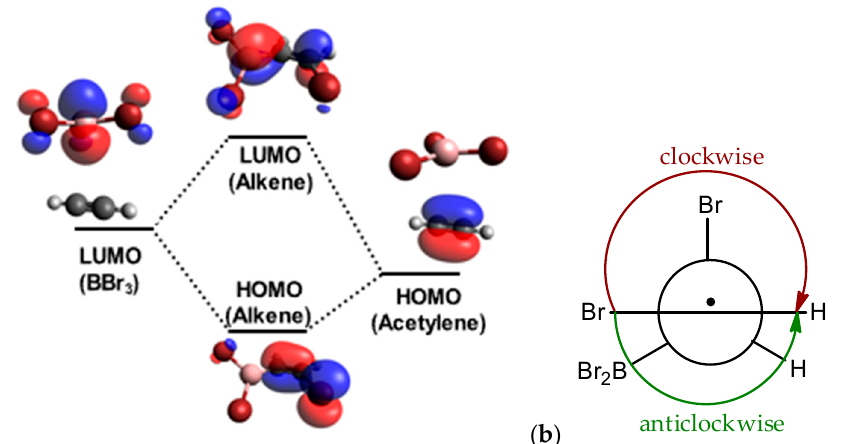
Figure 1. ( a ) Dispersion-corrected B3LYP and ( b ) MP2 Gibbs free energy profiles for BBr 3 addition to acetylene compared for several basis sets (cf. computational details). Key to atom colors: red = Br, pink = B, dark gray = C, light gray = H.